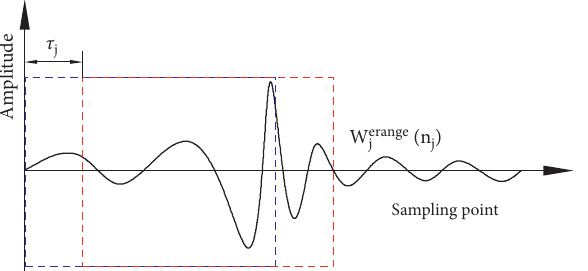
W fra ( n ) , and the part selected by the red j i